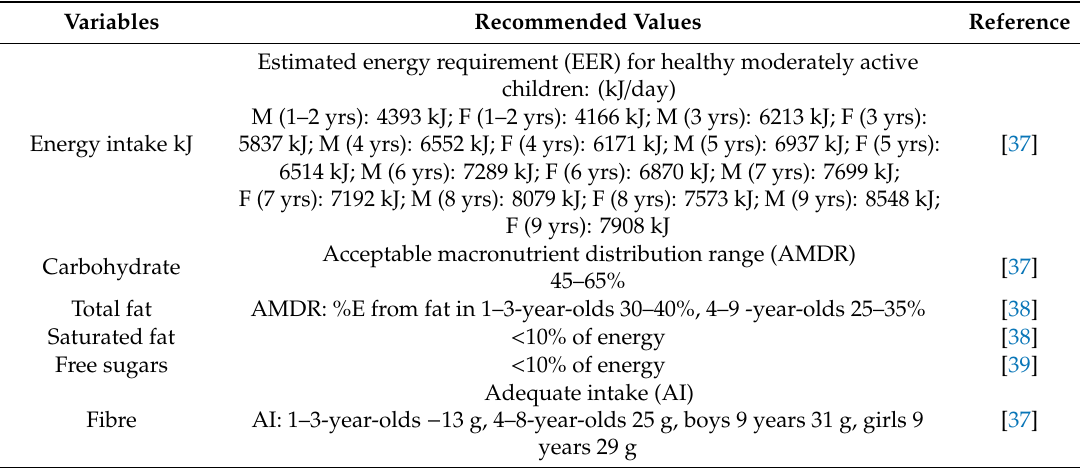
Table 1. Recommended cut-o ff values for dietary